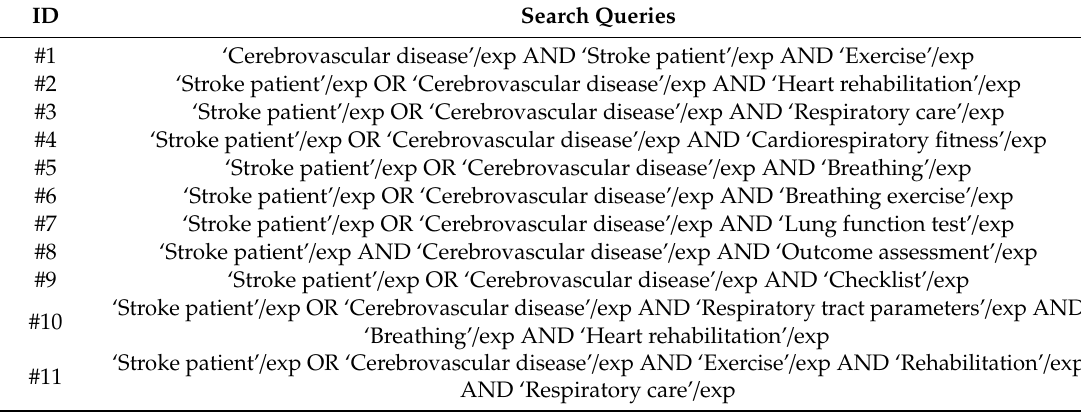
Table 2. Search strategy using Emtree terms in EMBASE.